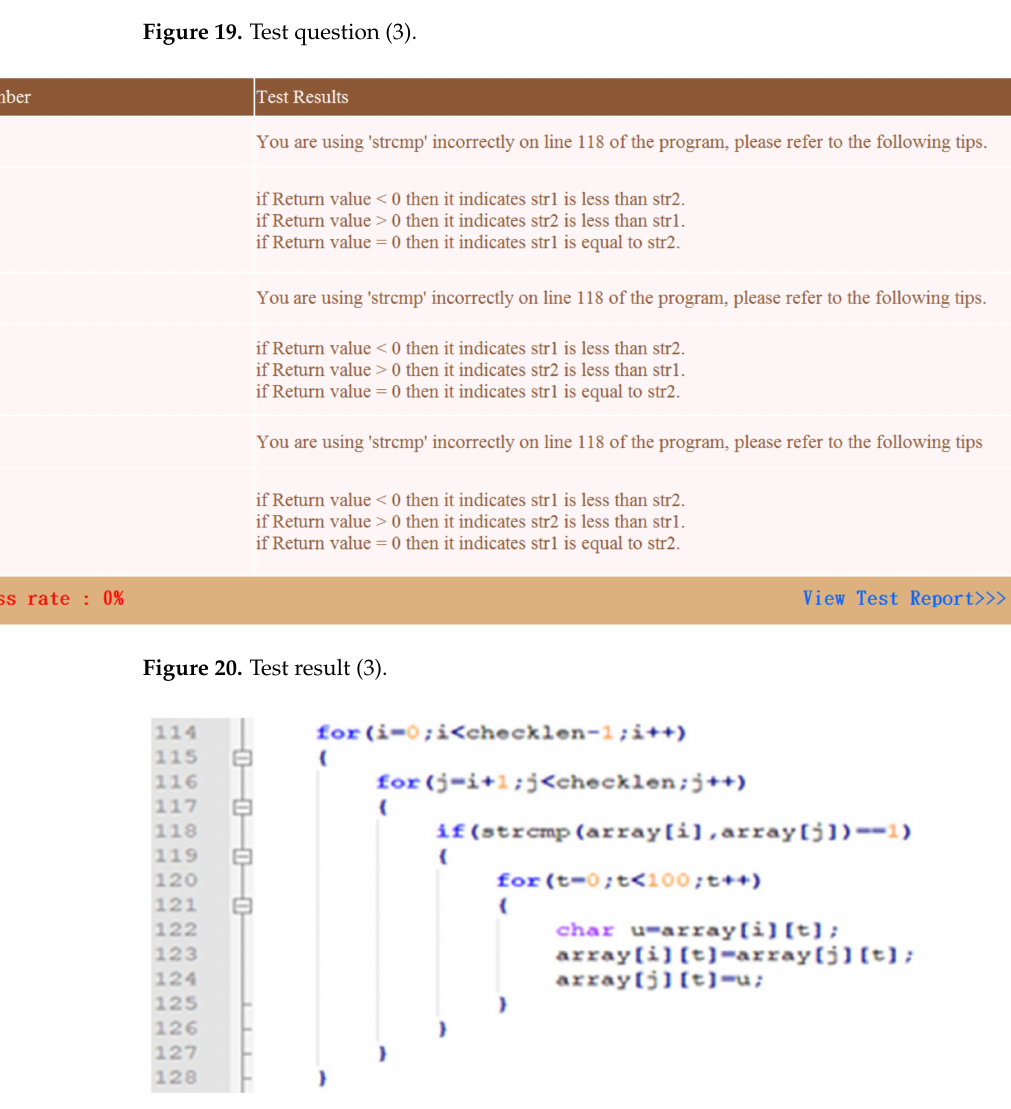
Figure 21. Example program